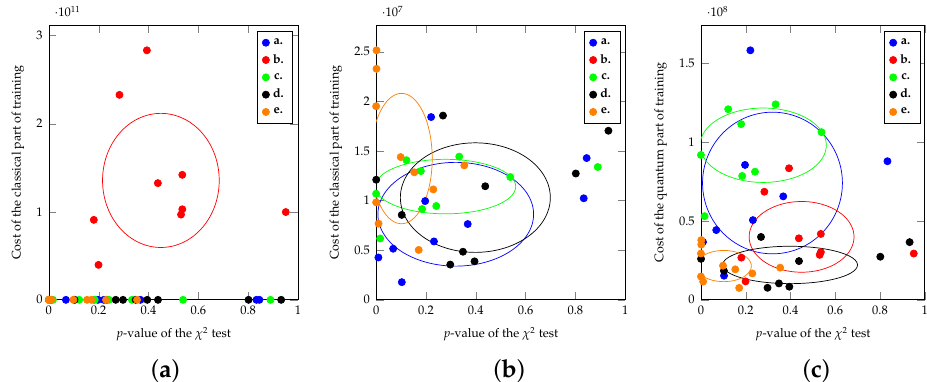
Figure 2. Visualization of the trade-off between training complexity and quality, for the test cases listed in Table 2. On the vertical axis, the complexity, calculated according to Equations (8) and (9). On the horizontal axis, the p -value of the χ 2 test after training is a metric for accuracy. Each dot represents a test execution, whereas dots with the same color are the result of different random initializations obtained with the same hyper-parameters. Tests are the same across the three plots. The best runs are in the bottom right corner of each plot since they have high accuracy and low computational cost. Each ellipse is a synthetic representation of the respective scenario: its center corresponds to the average of the converging runs in the scenario, and its radii correspond to the standard deviations. ( a ) Classical training complexity vs. quality. ( b ) Detail of subfigure ( a ). Here, test case ( b ) was excluded to allow rescaling in the vertical axis. ( c ) Quantum training complexity vs. quality. Table 2. Test cases used in Figure 2. More details can be found in Table A2a.